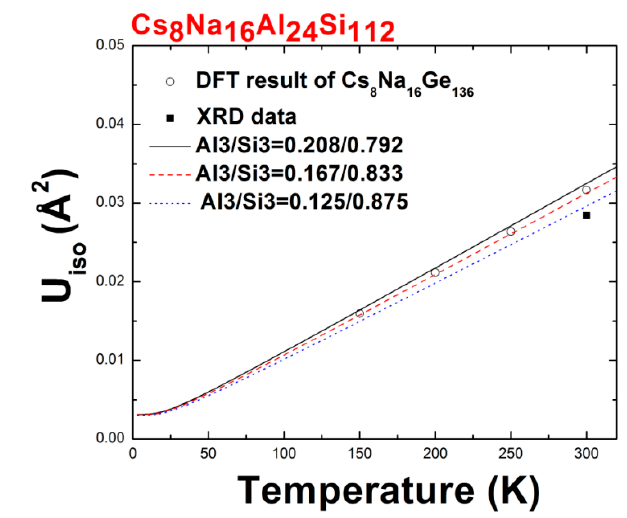
Figure 5. Theoretically and experimentally estimated isotropic atomic displacement parameters ( U iso ) of Cs in the 28-cage. The open symbols represent the data corresponding to Cs vibration in Cs 8 Na 16 Ge 136 [22]. The solid symbol denotes the measured value of U iso regarding Cs rattling in Cs 8 Na 16 Al 24 Si 112 .